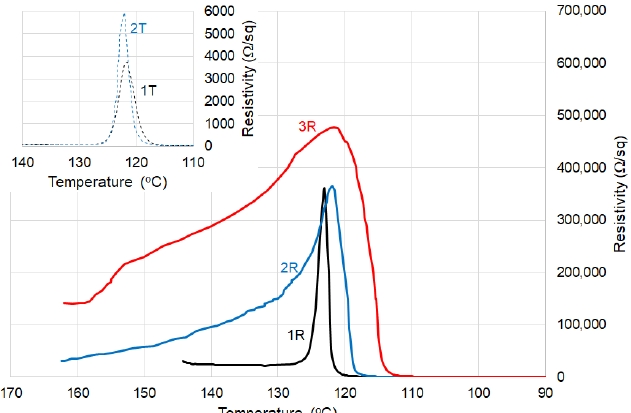
Figure 11. Resistivity vs. temperature for (CB + Gr)/HD samples on repeated temperature cycles, cooling portions: 1T, 2T – thermoplastic (D = 0 kGy) cycles 1 and 2 respectively; 1R, 2R, 3R — cross-linked (D = 150 kGy), cycles 1, 2 and 3, respectively. Note: because of weak intensity of the peaks of thermoplastic material. These curves are shown in the inset.